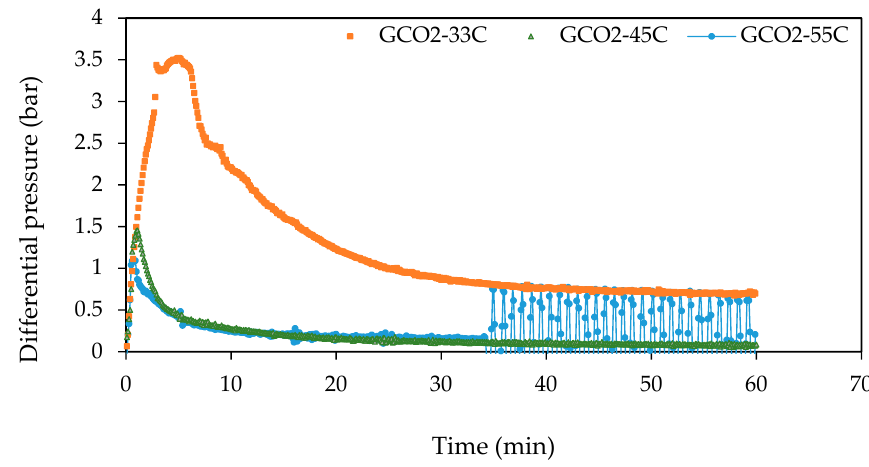
Figure 10. Effect of experimental temperature on the differential pressure profile of high-fluid-pressure GCO 2 –oil displacements conducted at 0.4 mL/min and 70 bar.